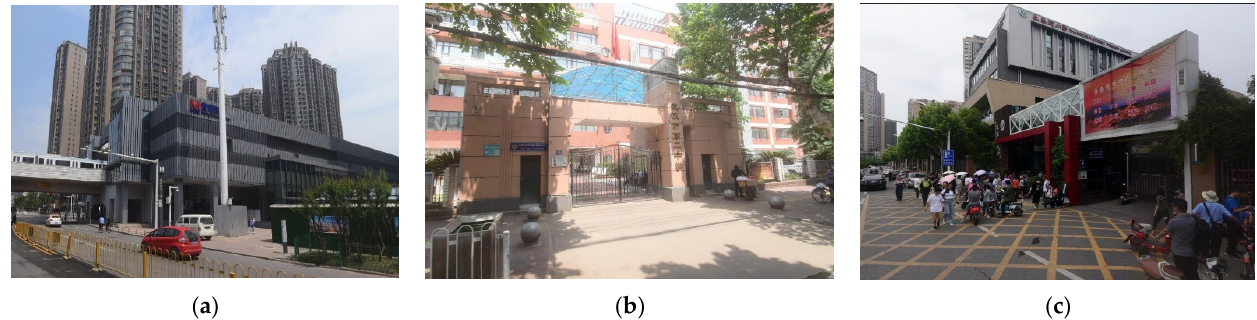
Figure 8. Huangpu area build environment photos. ( a )Huangpu Road rail transit station; ( b ) Wuhan No.2 High School; ( c ) Changchun Street Primary School.